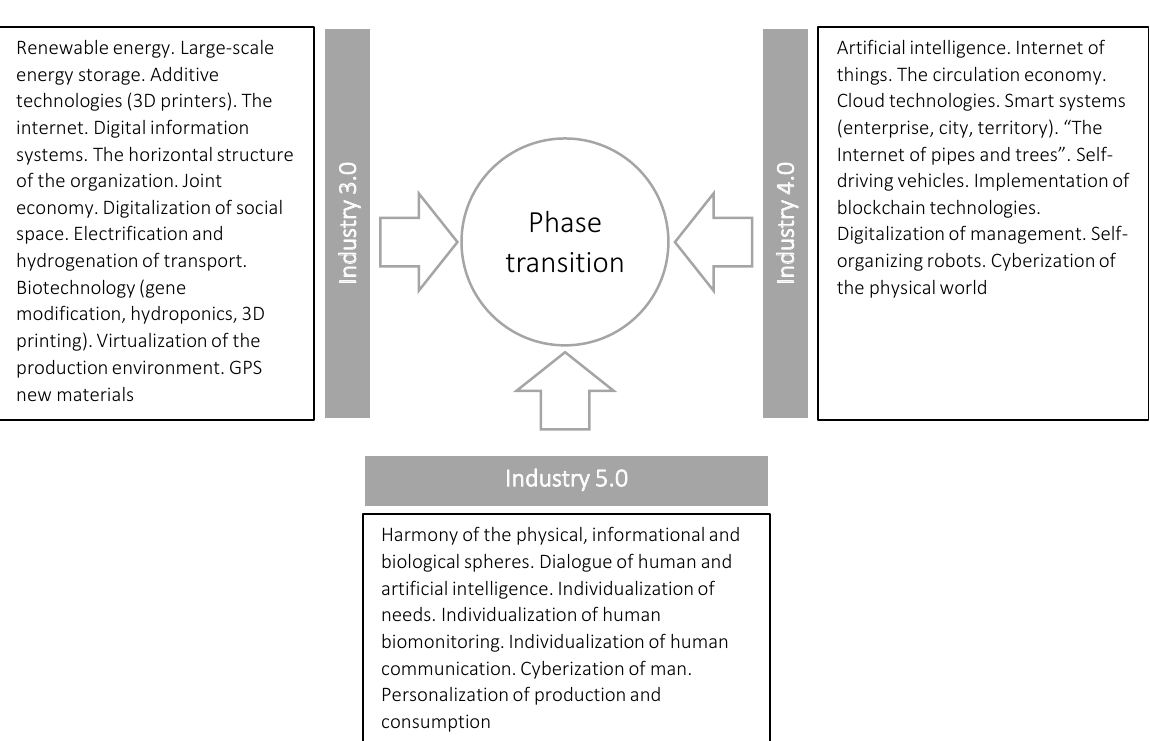
Figure 1. The role of industrial revolutions in the implementation of the modern phase transition